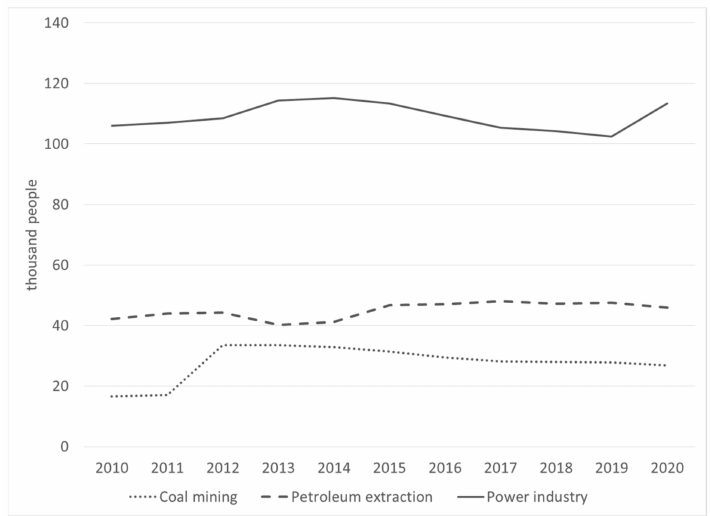
Figure 2. Energy sector employment. Source: Ministry of Economy of Kazakhstan “Industry of Kazakhstan”, various